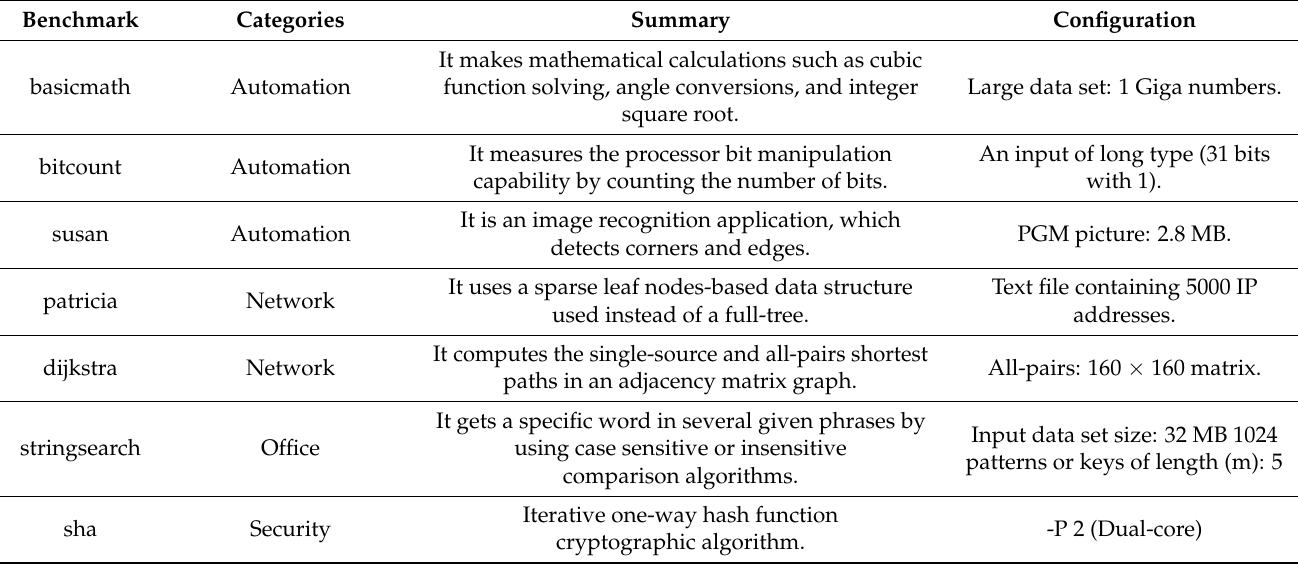
Figure 9. Linux boot time (wallclock) for different scenarios: ( a ) boot Linux time in different platforms; ( b ) Instruction Fetching profiling for Setup#2:PetaLinux; ( c ) Instruction Fetching profiling for Setup#3:QEMU-VP. Table 2. ParMiBench benchmarks descriptions with input